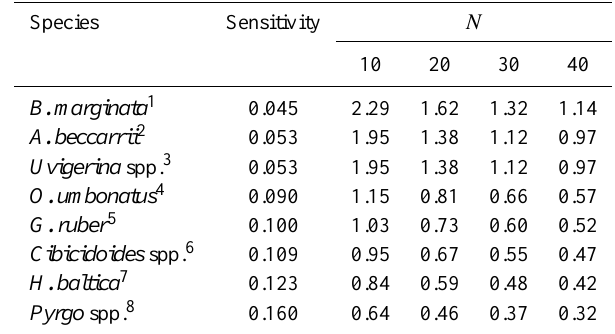
Table 4. The uncertainty in temperature ( ◦ C) as a temperature range ( T max − T min ) based on the averaged standard deviation (16.3%) of the culture experiments. T max/min is based on the Mg/Ca value at √ n ). Temperature a temperature plus or minus the uncertainty ( σ / values are calculated using the species-specific calibrations avail- able for each species of foraminifera. (1) This study, (2) Toyofuku et al. (2011), (3) Elderfield et al. (2006), (4) Rathmann et al. (2004), (5) Anand et al. (2003), (6) Lear et al. (2002), (7) Rosenthal et al. (2011), (8) Wit et al. (2012).